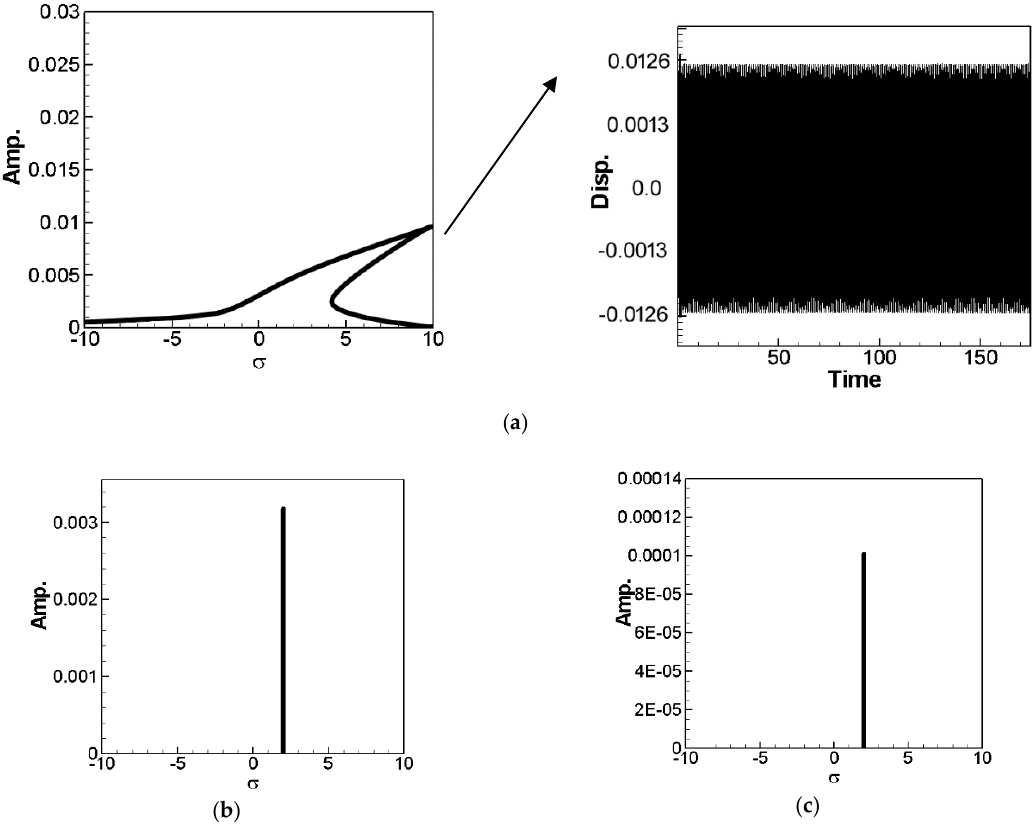
Figure 14. Fixed point plots when exciting the 3rd mode,( a ) 3rd mode Fixed point plot and time response,( b ) 1st mode Fixed point plot,( c ) 2nd mode Fixed point plot .